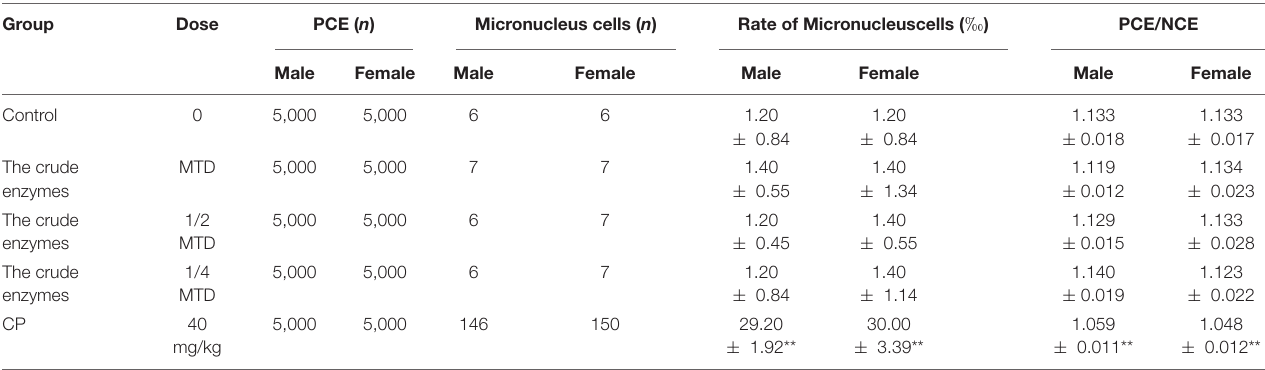
TABLE 6 | The results of bone marrow micronucleus